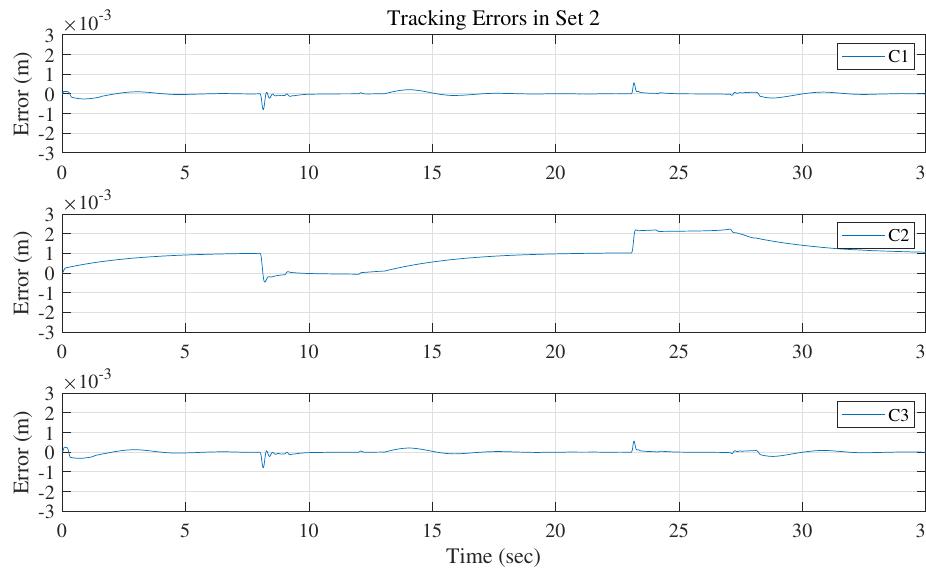
Figure 7. Motion tracking errors comparison in Set 2.